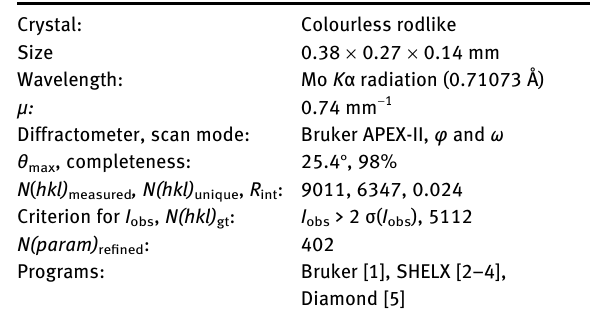
Table  : Data collection and